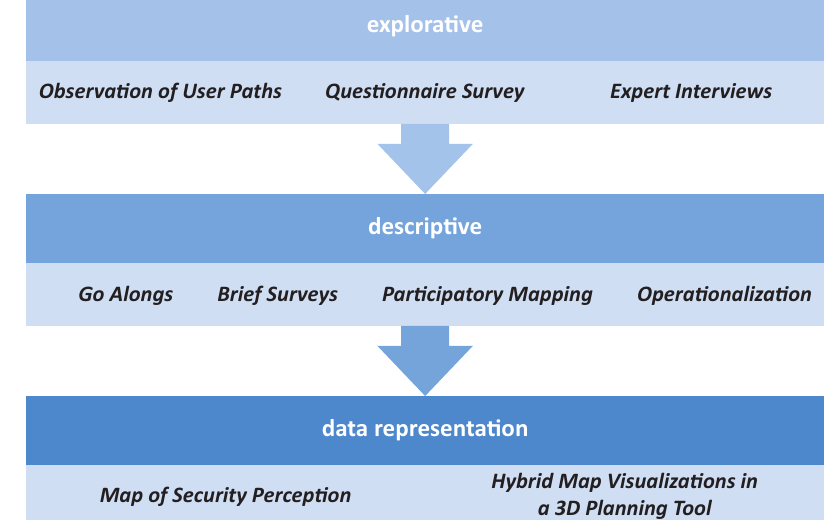
Figure 1. Overview of the three research phases and their methods for investigating spatial perceptions. Urban Planning, 2021, Volume 6, Issue 1, Pages